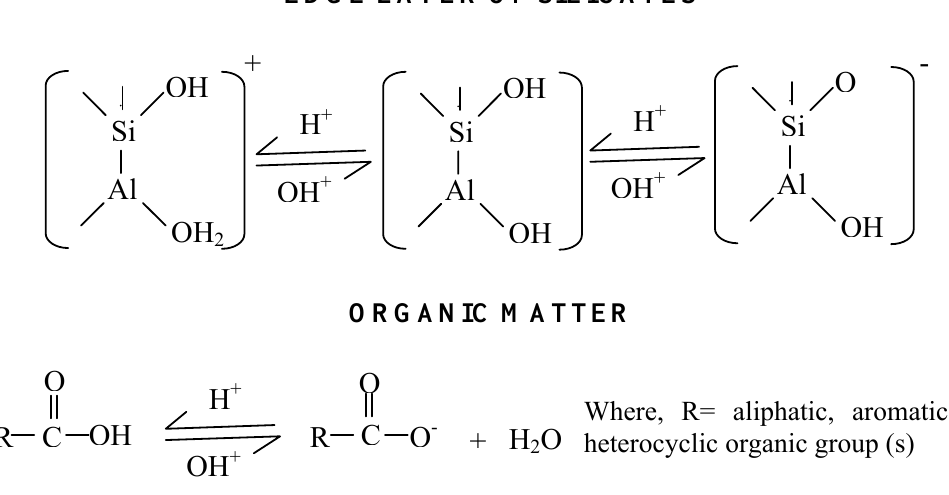
FIGURE 1. Effect of pH on charge generation in various inorganic colloids and organic matter. (In this